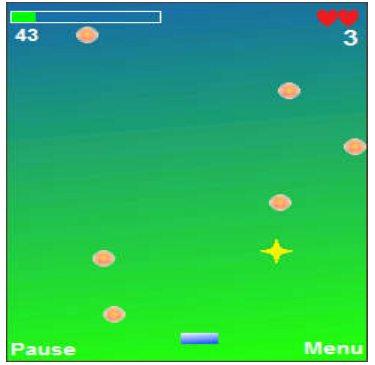
Figure 19. Avoid demo